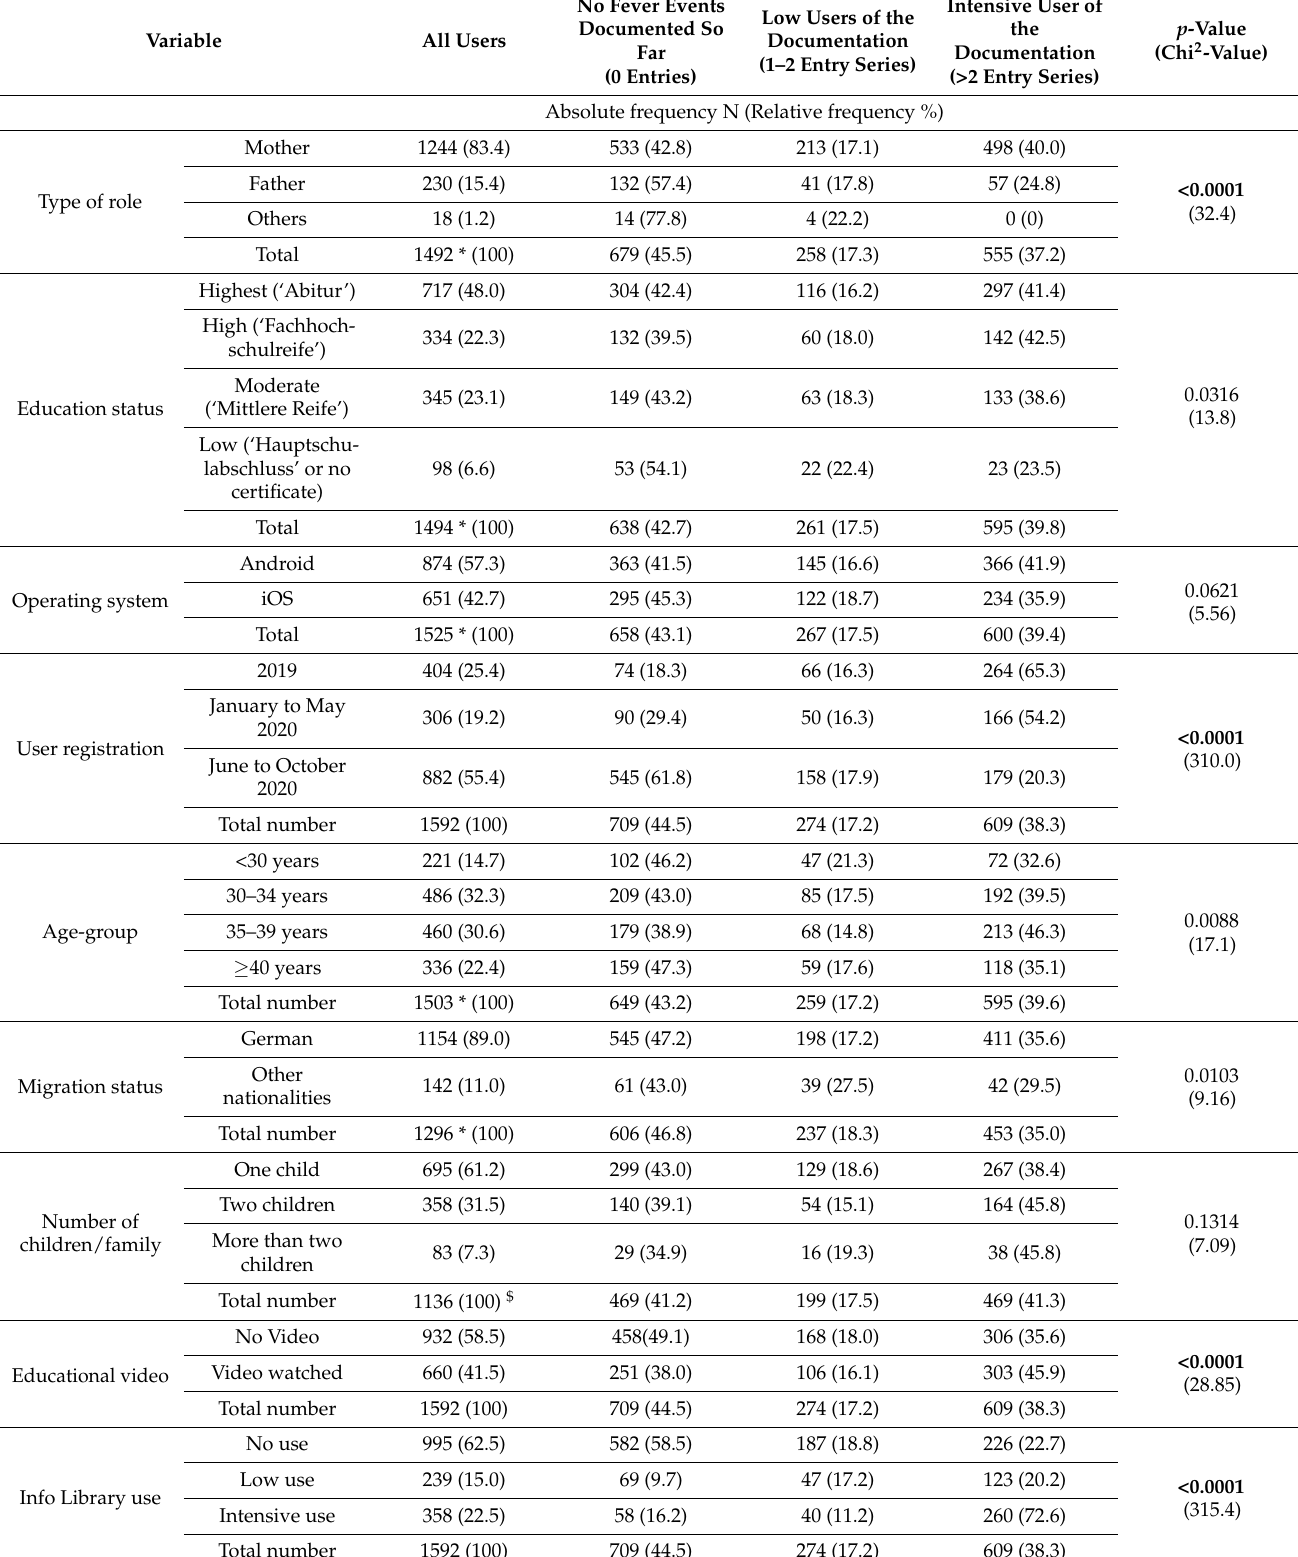
Table 3. Use of documentation function depending on the status of parents, education, age, and